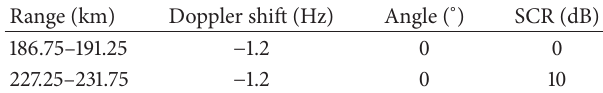
Table 3: Range-spread targets